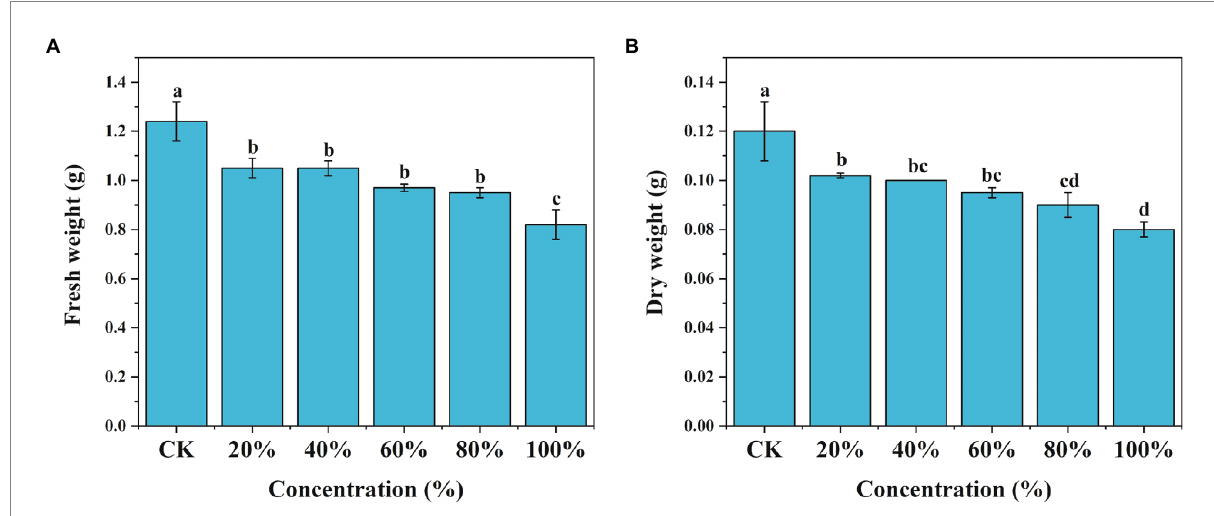
FIGURE 1 Effects of root exudates of M. truncatula on its fresh and dry weight. (A) M. truncatula fresh weight, (B) M. truncatula dry weight. Values represent means±SD of four biological replicates. Different letters above the bars indicate a significant difference ( p <